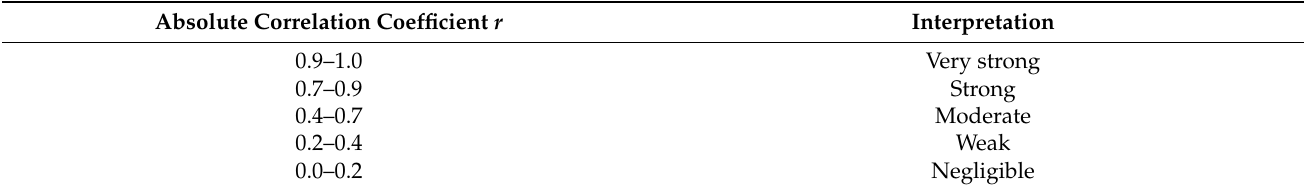
Table 4. Correlation classification used for this study. Modified from Hinkle et al.